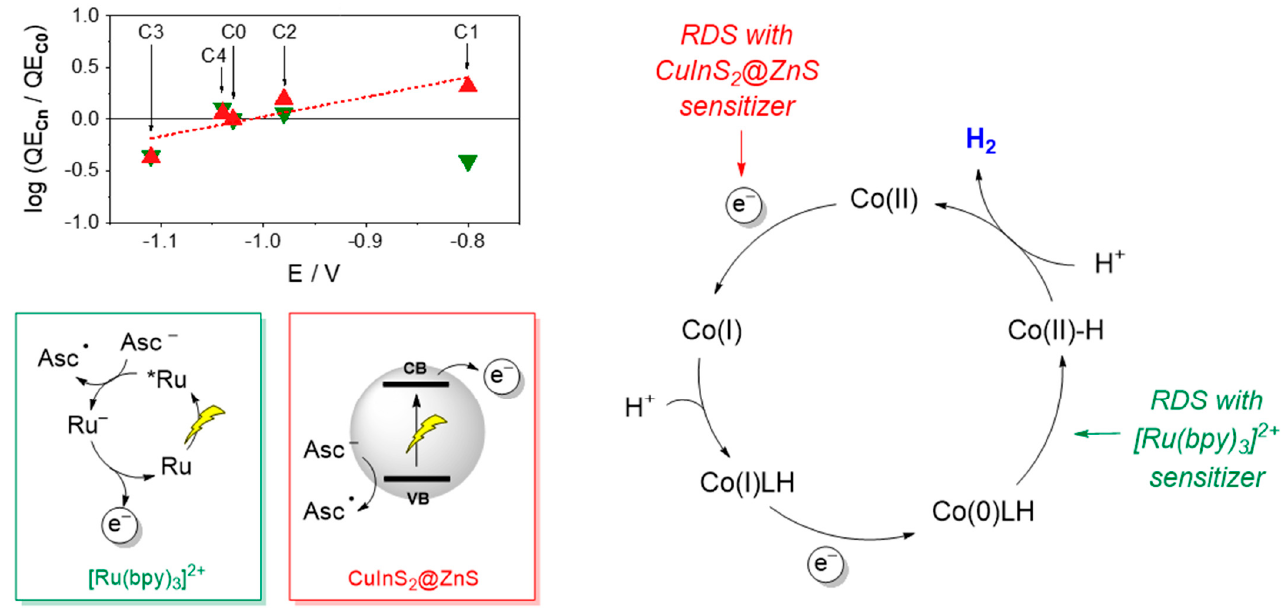
Figure 6. Plot of the log(QE Cn /QE C0 ) (where n = 0–4) at pH 4 vs. the half-wave potential of the catalytic wave in acetonitrile for C0–C4 (see Ref. [27]) for the light-driven catalytic data obtained with the photochemical systems based on core-shell CuInS 2 @ZnS QDs (red triangles) and [Ru(bpy) 3 ] 2+ (green triangles) as the sensitizers and schematic representation of the main processes and rate- determining steps involved in photochemical hydrogen evolution with either core-shell CuInS 2 @ZnS QDs or [Ru(bpy) 3 ] 2+ as the sensitizer, ascorbate as the sacrificial donor, and the cobalt complexes C0–4 as the HECs. Abbreviations: CB = conduction band; VB = valence band; Asc − = ascorbate anion; Asc ● = ascorbate radical; RDS = rate-determining step.